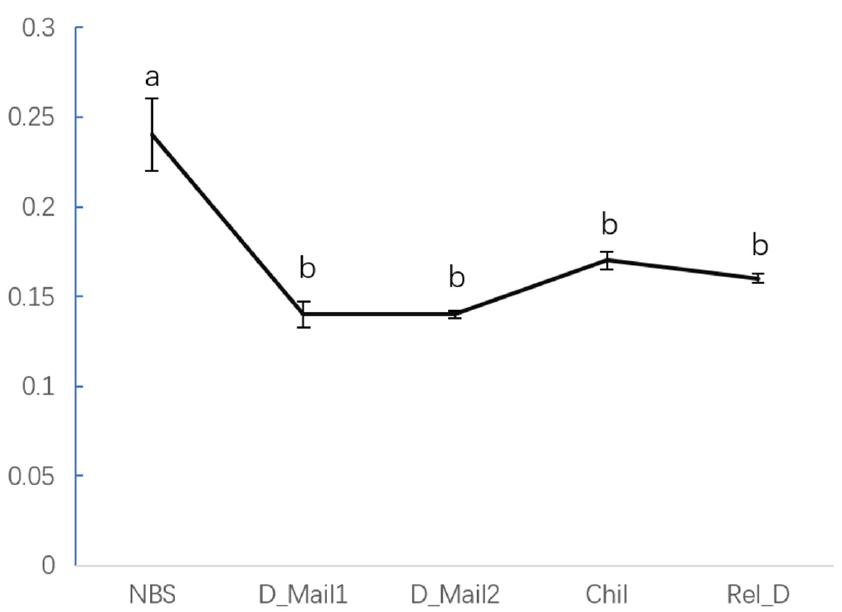
Figure 5. Levels of juvenile hormone 1 (JH1) in various stages of the beet webworm. Different letters represent significant differences.